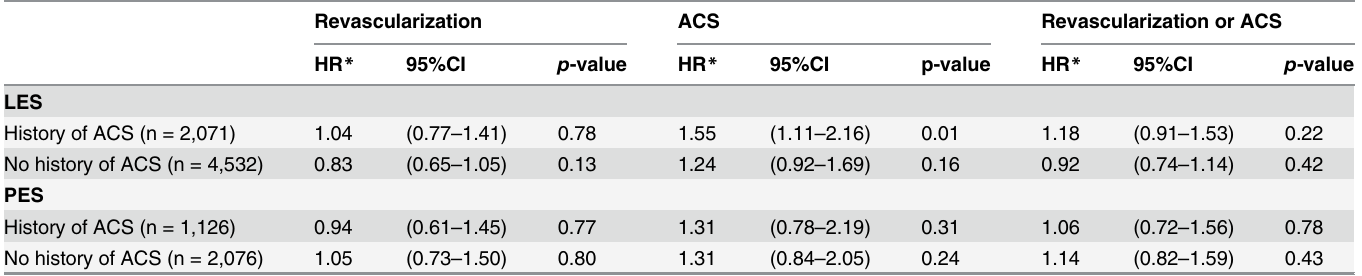
Table 4. Stratified analysis of outcomes by history of ACS for clopidogrel versus clopidogrel added on PPI after DES